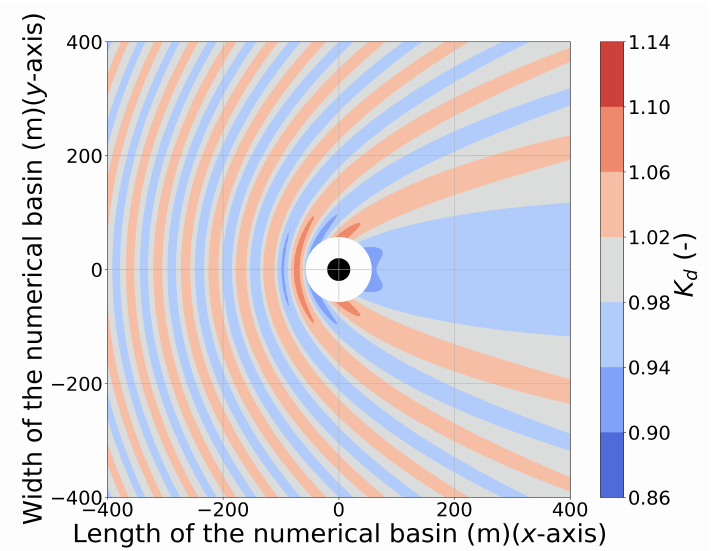
Figure 5. K d disturbance coefficient results for a single HCWEC interacting with a regular wave with H = 2.0 m, T = 8.0 s and θ = 0 ◦ . The coupling region is filled using a white solid circle which includes the WEC (indicated by a black solid circle). Incident waves are generated from the left to the